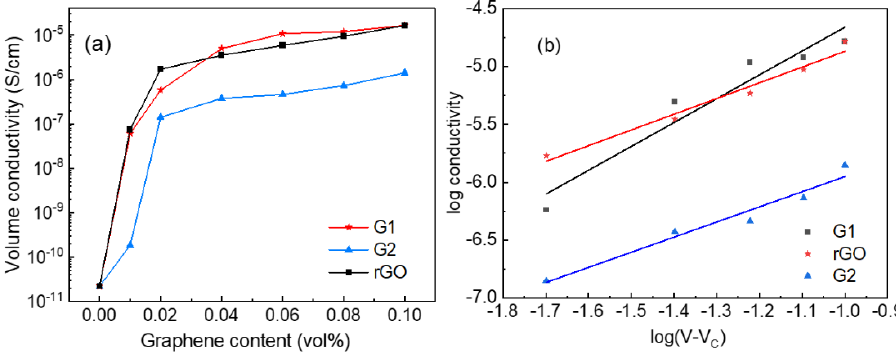
Figure 7. ( a ) Volume conductivity of GN-CNT 0.2 /PU composite film as a function of the volume fraction of GN; ( b ) log( σ )-log(V-V c ) curves of CNT 0.2 /PU composite film doped with different kinds of graphene.